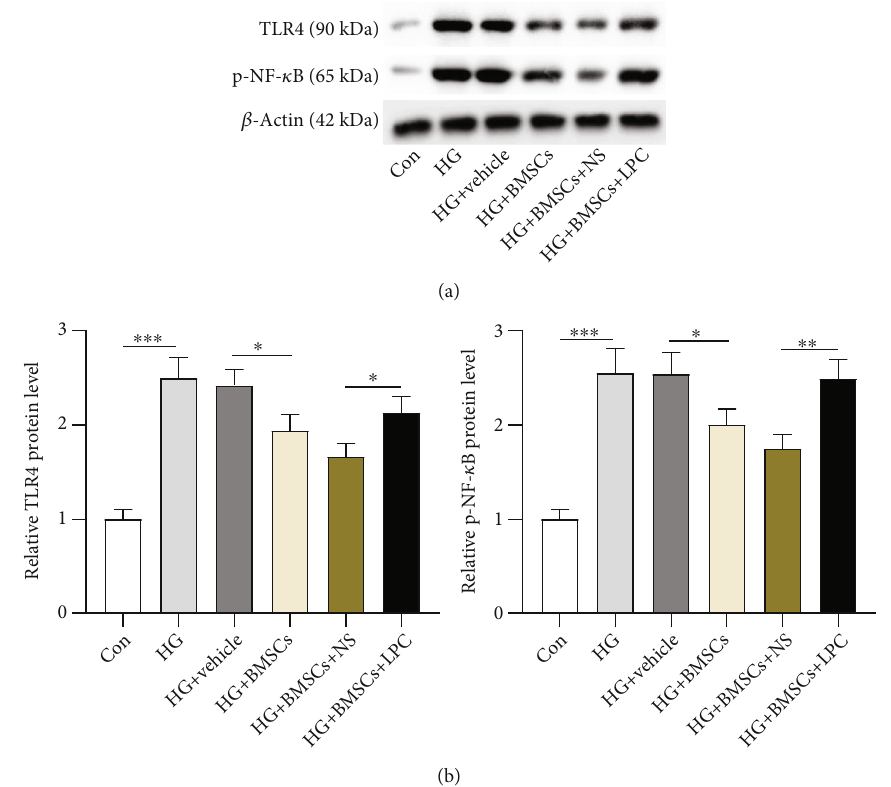
Figure 6: LPC activates the TLR4/NF- κ B signaling pathway. (a, b) The levels of TLR4 and p-NF- κ B proteins in HG-treated HRMECs after BMSC coculture or LPC treatment were examined by western blotting. ∗ p < 0 : 05 , ∗∗ p < 0 : 01 , and ∗∗∗ p < 0 : 001